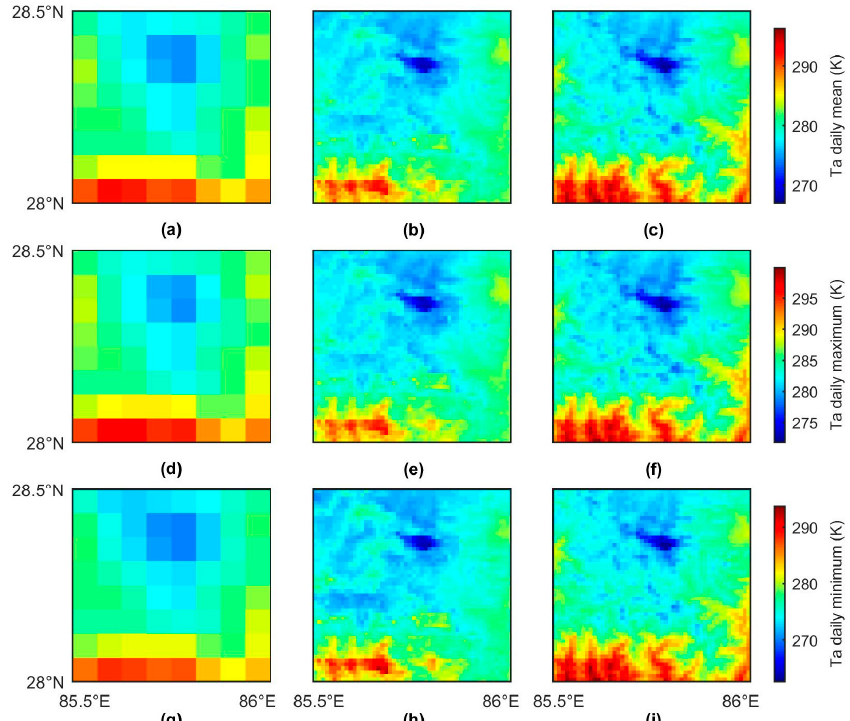
Figure 7. Spatial distribution patterns of CLDAS and remote sensing based Ta on 8 August 2013 (DOY 220): ( a ) CLDAS mean Ta; ( b ) SML estimated mean Ta; ( c ) PML estimated mean Ta; ( d ) CLDAS maximum Ta; ( e ) SML estimated maximum Ta; ( f ) PML estimated maximum Ta; ( g ) CLDAS minimum Ta; ( h ) SML estimated minimum Ta; and ( i ) PML estimated minimum Ta.